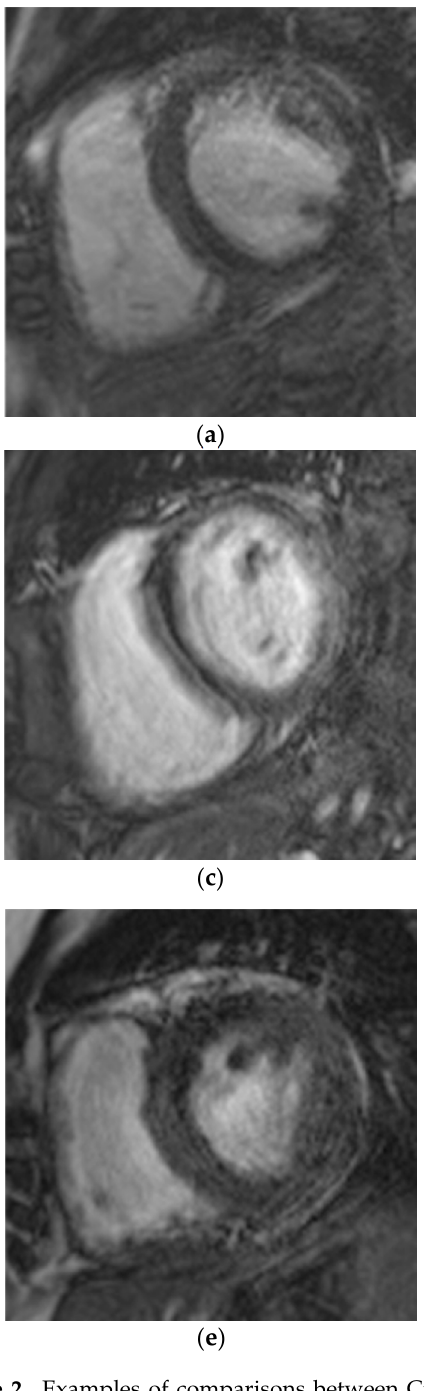
cavity short-axis views acquired with ( a , c , e ) Cine ref and ( b , d , f ) CS rt . The three patients were ( a , b ) a 74-year-old man suffering from atrial fibrillation, ( c , d ) a 37-year-old woman screened for a genetically proven arrhythmogenic right ventricular cardiomyopathy, ( e , f ) a 63-year-old woman scanned for a second-degree atrioventricular block. The image quality assessment demonstrated: ( a ) Likert scale = 1/4, EuroCMR score = 3/10, ε Cineref = 0.051 pixel − 1 ; ( b ) Likert scale = 3/4, EuroCMR score = 0/10, ε CSrt = 0.067 pixel − 1 ; ( c ) Likert scale = 1/4, EuroCMR score = 3/10, ε Cineref = 0.015 pixel − 1 ; ( d ) Likert scale = 3/4, EuroCMR score = 1/10, ε CSrt = 0.050 pixel − 1 ; ( e ) Likert scale = 1/4, EuroCMR score = 3/10, ε Cineref = 0.023 pixel − 1 ; ( f ) Likert scale